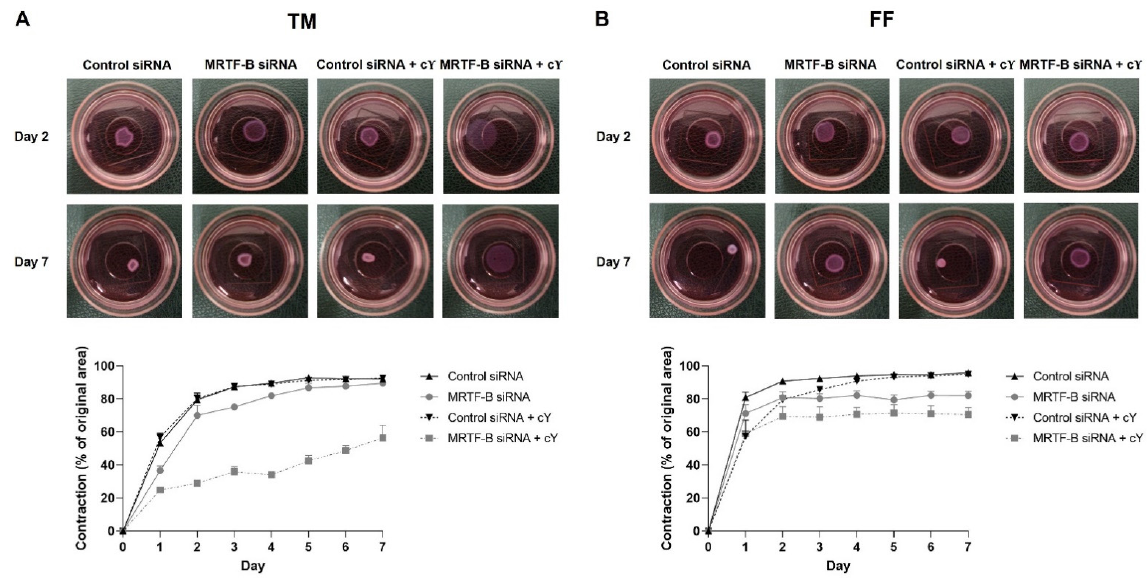
Figure 6. Three-dimensional collagen contraction assay of human ( A ) TM and ( B ) FF cells after transfection with four lipid nanoparticles (LNP-Control siRNA, LNP-MRTF-B siRNA, LNP-Control siRNA + cY, LNP-MRTF-B siRNA + cY) throughout the 7 days. Representative gel areas on day 2 and day 7 are shown.